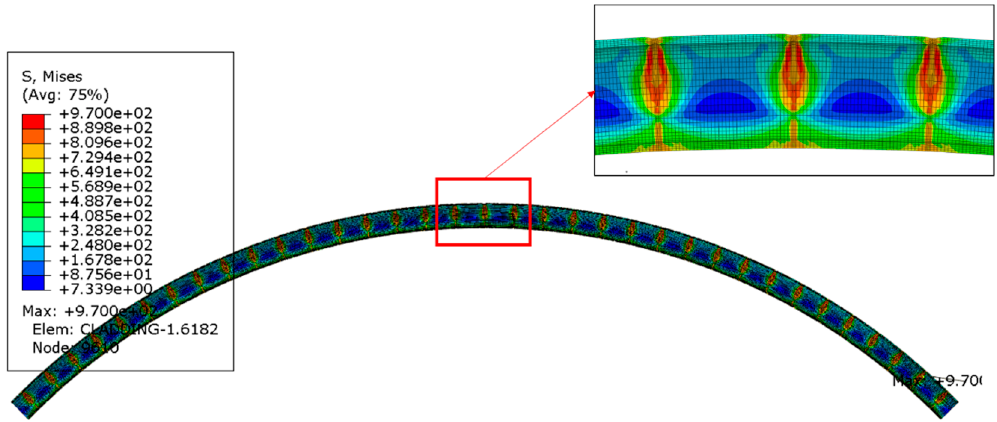
Figure 6. Deformed shape and stress distribution of cladding (fully bonded interface).